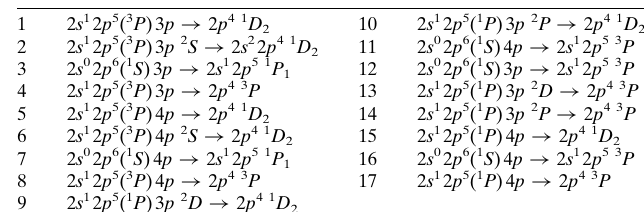
Table 1 Assignments of the peaks in Fig.